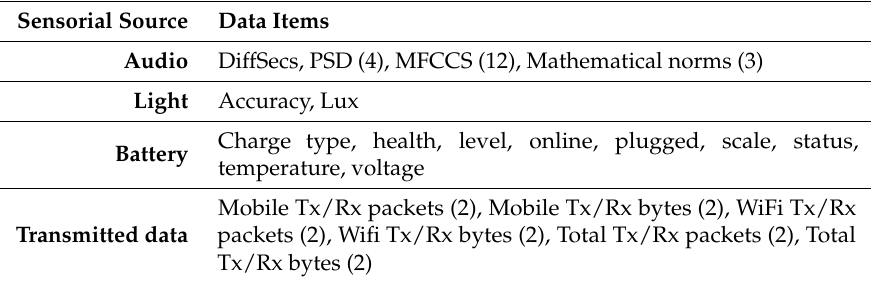
Table 3. Data items per sensorial data